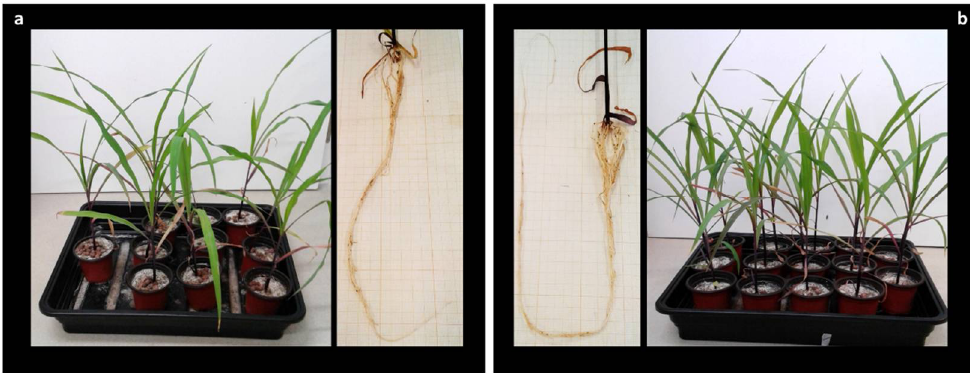
Figure 7. Five-week-old plants of maize. ( a ) Plant growth with alginate beads without bacteria. ( b ) Plant growth with alginate beads containing B. subtilis . The roots of the plants inoculated with B. subtilis were statistically significantly longer and more branched than the root system of the control plants.